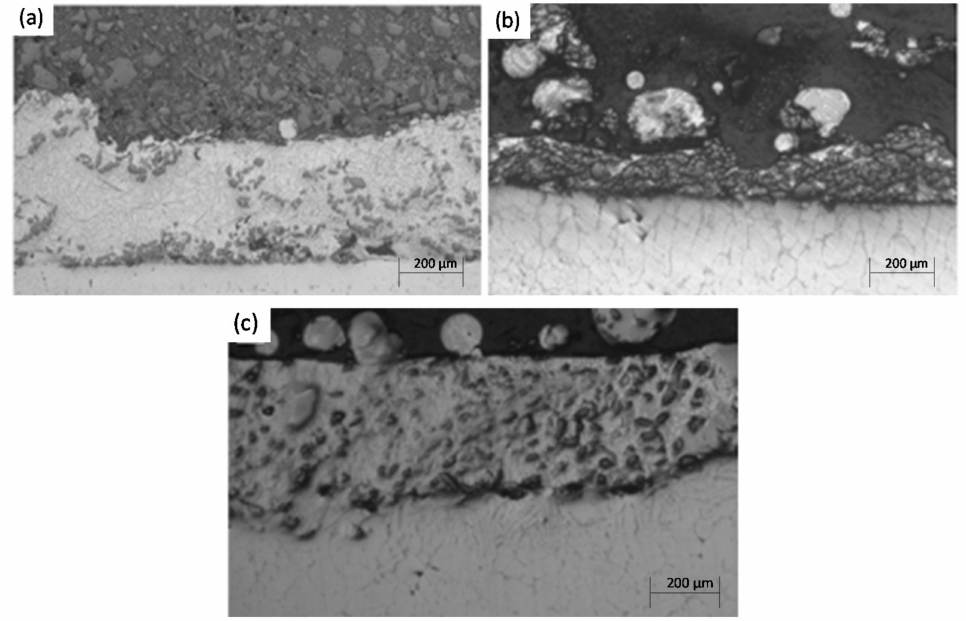
Figure 1. Laser cladding coatings on AA6082 aluminum alloy cross-section ( a ) Al12Si/SiC, ( b ) Al40Si/SiC, and ( c ) Al12Si-Ti/SiC. The deposition efficiency was calculated by Equation (1)